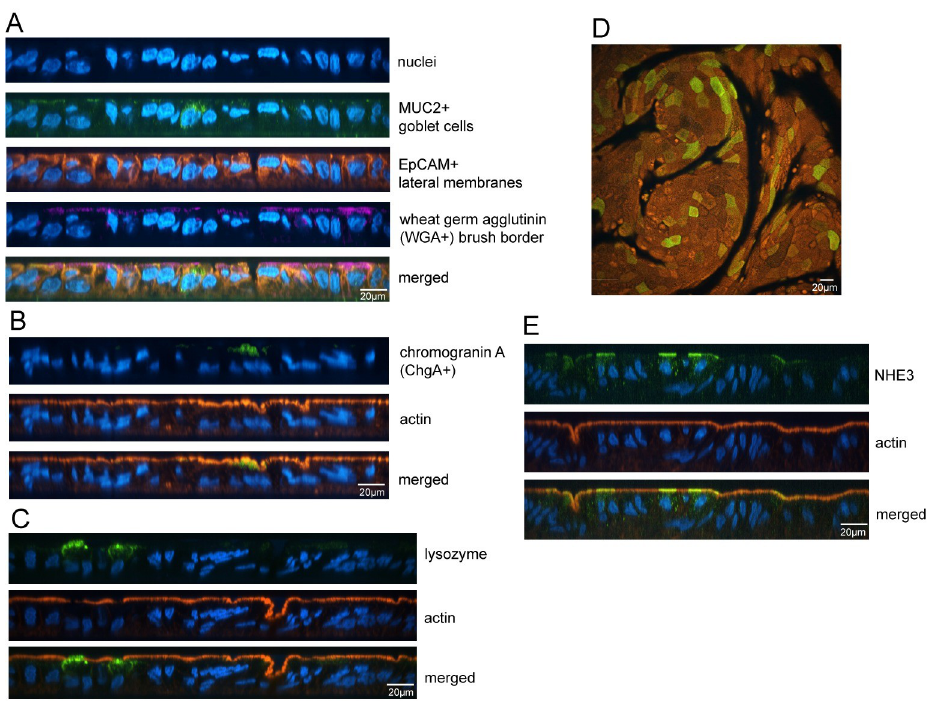
Fig 5. Human ileal enteroids include specialized intestinal cell subtypes. Differentiated enteroid monolayers (35I) were fixed and stained with Hoescht for nuclei in all panels. Monolayers were stained with antibodies against mucin (MUC2) for goblet cells, epithelial cell adhesion molecule (EpCAM) for lateral membranes, and wheat germ agglutinin (WGA) for brush border (A). Monolayers were stained with antibody against chromogranin A (ChgA) for enteroendocrine cells (B). Monolayers were stained with antibodies against lysozyme for Paneth cells (C). Monolayers were stained with antibodies against the NHE3 ion transporter (D, E). Confocal microscopy was used to visualize XY and XZ